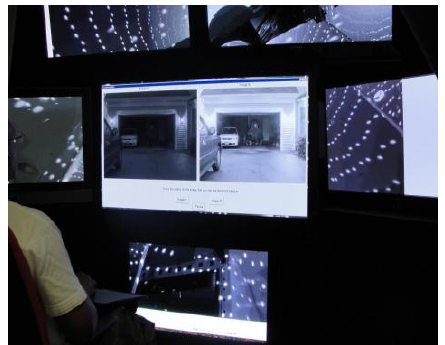
Figure 6. A Picture of the Visual Perception